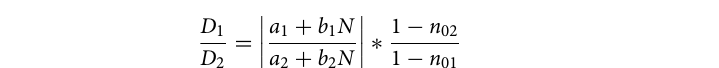
Figure 9. Comparison of pore area ratio damage degree and model